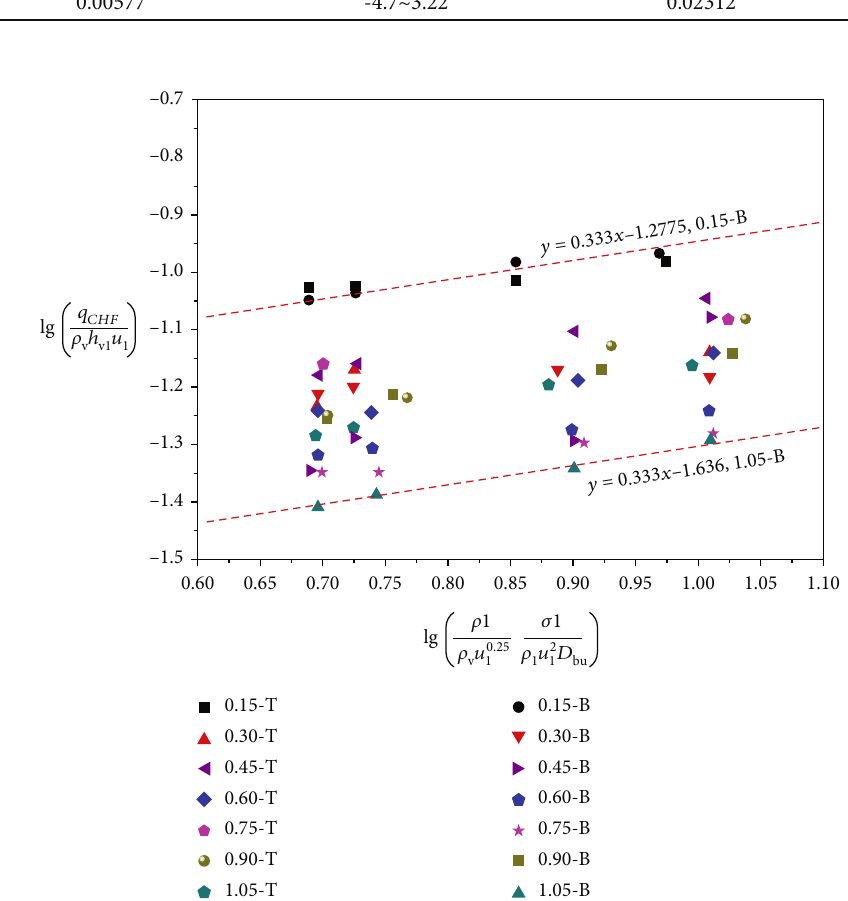
Figure 24: High-pressure